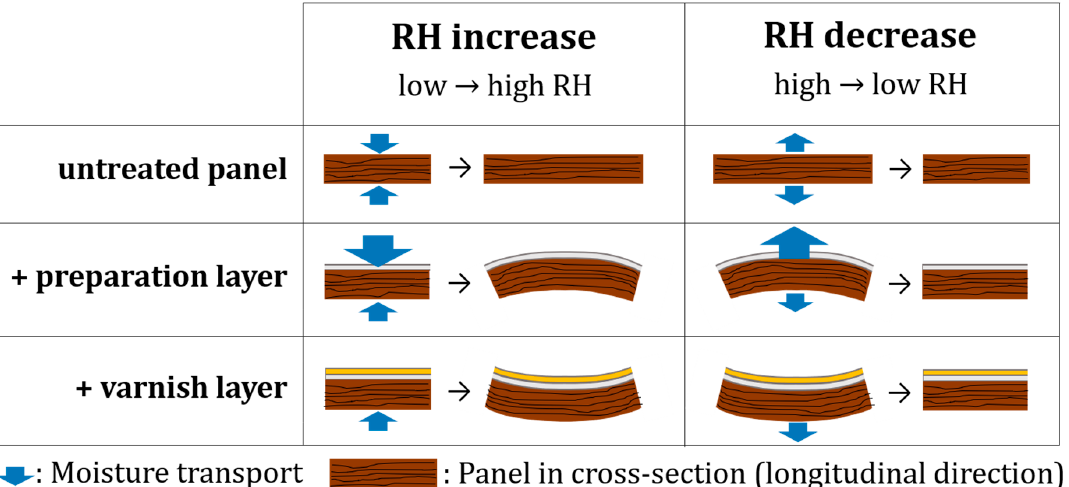
Figure 5. Schematic overview of the dimensional response of quarter sawn panels (see Figure 2 for the setup). The cross-sections in the longitudinal direction visualize the response for untreated wood, wood with preparation layer and wood with preparation layer and varnish, for increasing and decreasing RH conditions. The moisture transport at the preparation layer is enhanced compared to the opposite untreated side, while this transport at the surface covered with a varnish layer is inhibited compared with the untreated opposite side.